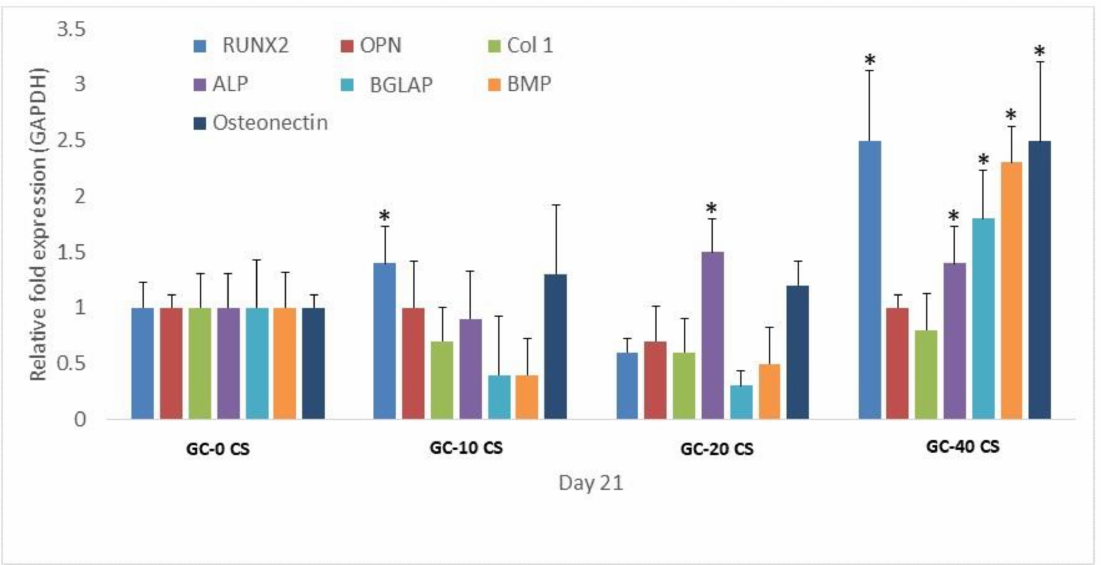
Figure 8. Osteogenic gene expression (Runx2, osteopontin (OPN), type-1 collagen (Col1), alkaline phosphatase (ALP), bone gamma-carboxy glutamic-acid-containing protein (BGLAP), bone morphogenic protein (BMP), osteonectin) of hBMSCs seeded in GC-0 CS, GC-10 CS, GC-20 CS, and GC-40 CS scaffolds at day 21. Statistical analyses: One-way ANOVA followed by Post-Hoc LSD test; * p < 0.05 indicates level of statistical